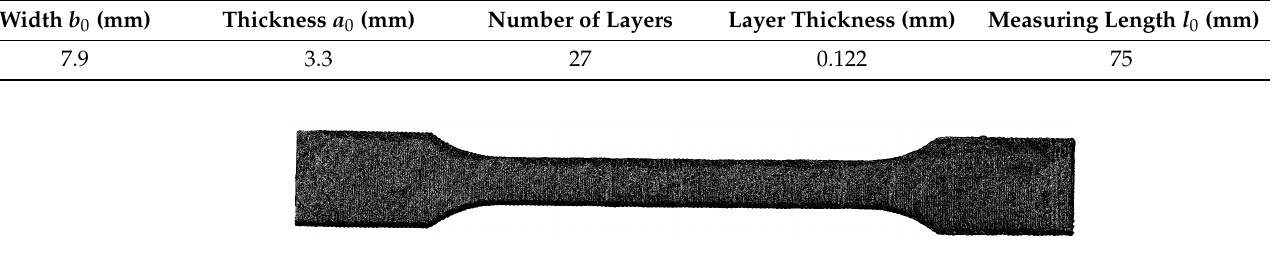
Figure 9. Scanned sample after static tensile test. 2.2. Numerical Implementation In order to perform analysis with the Finite Element Method, a simulation model was developed in the Abaqus CAE 6.6 program. Due to the differences in the dimensions of